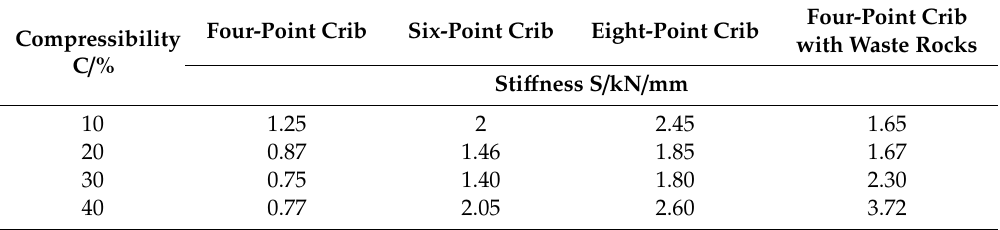
Table 3. Comparison of the sti ff ness of the wooden cribs for increasing